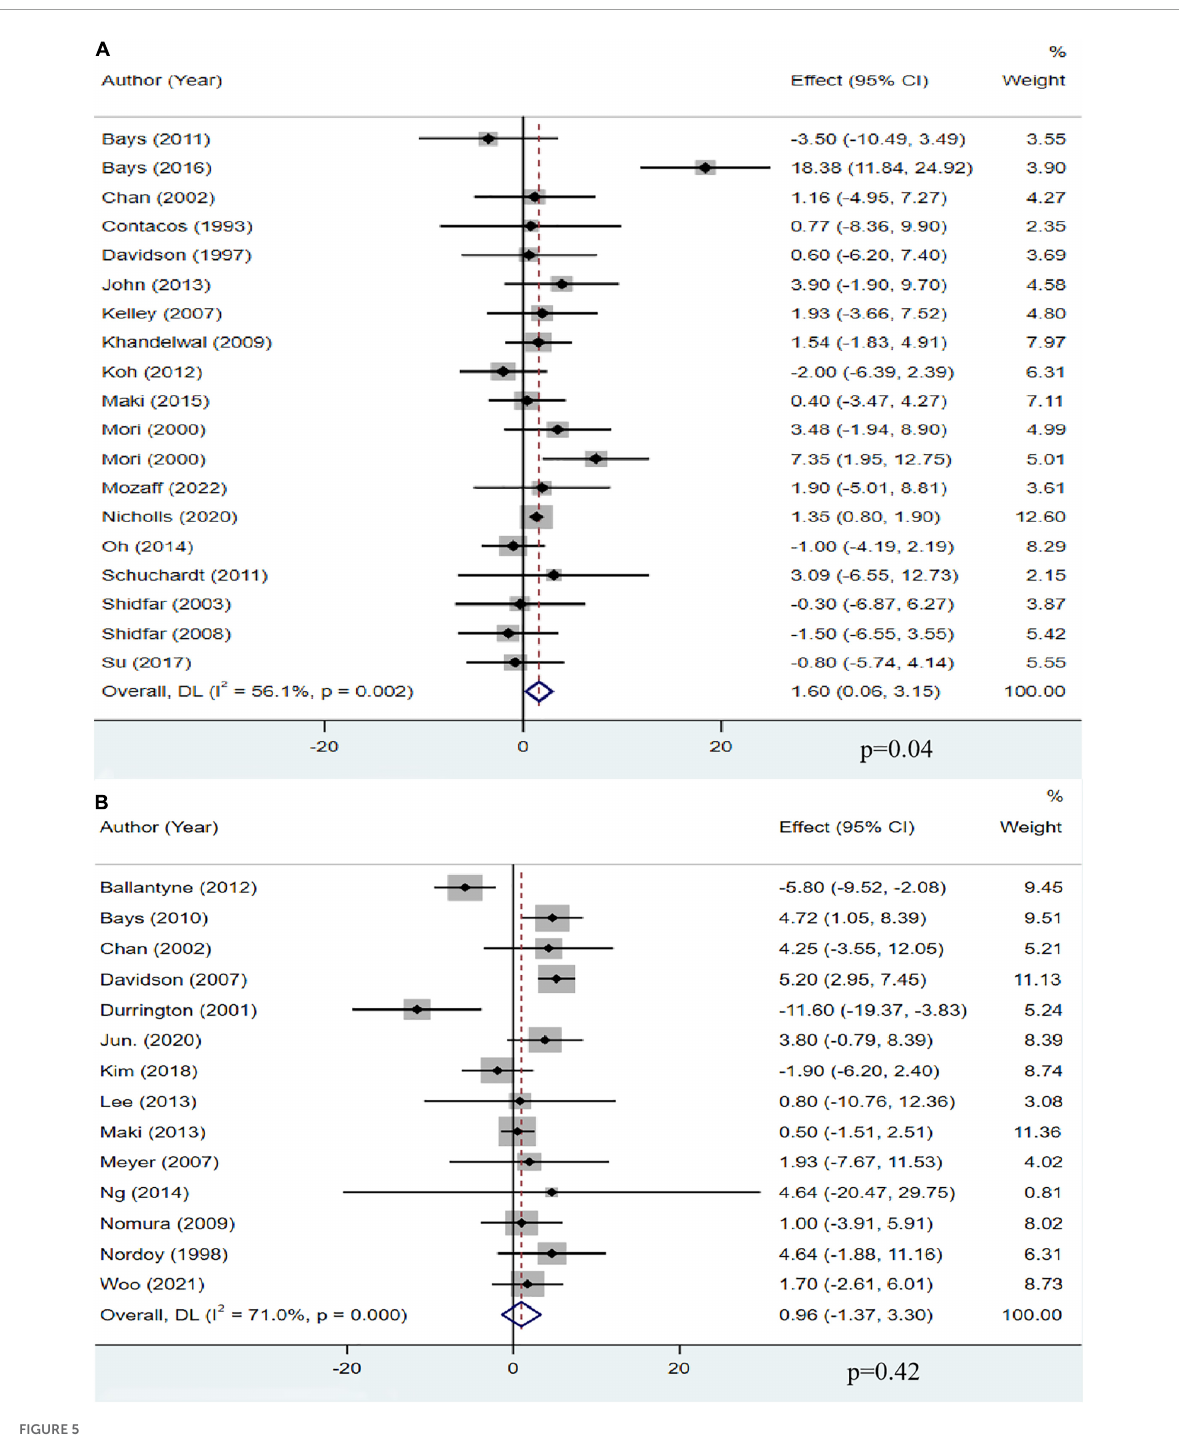
VLDL-C, and non-HDL-C also showed a significant reduction both with OM3-FA monotherapy and integrated treatment of OM3-FA and statins. Third, OM3-FA monotherapy elevated LDL-C and HDL-C levels, while combined therapy of statins